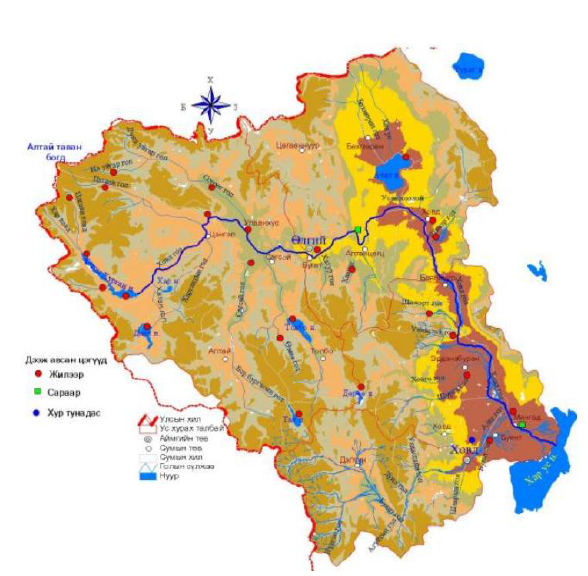
Figure 1. The points of the